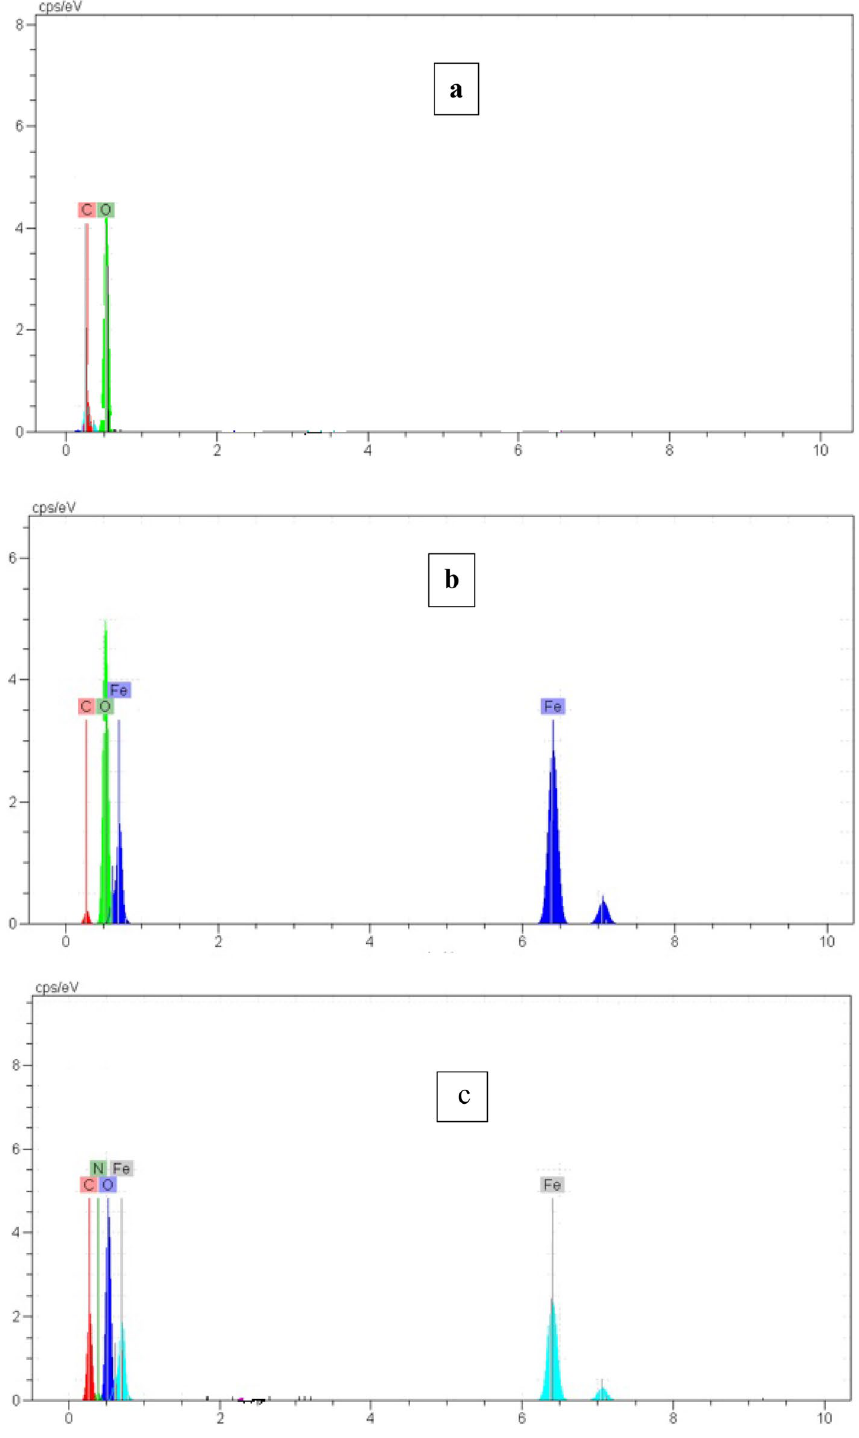
Figure 8. EDX analysis of ( a ) GO, ( b ) GF and ( C ) GFLE